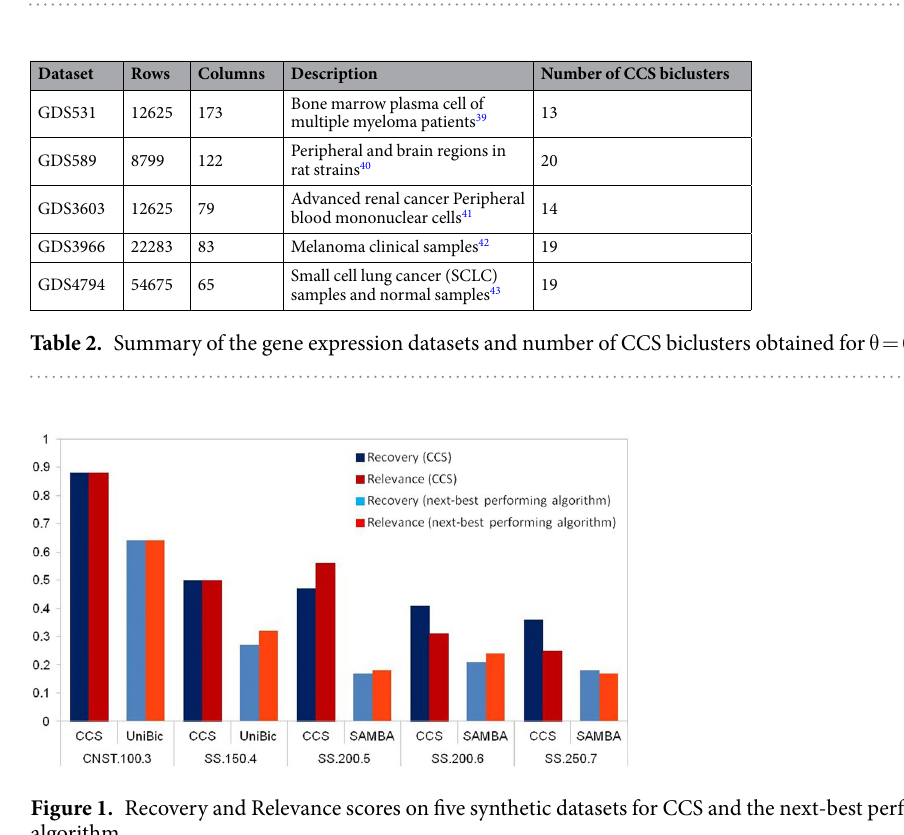
Table 1. Summary of the synthetic datasets.